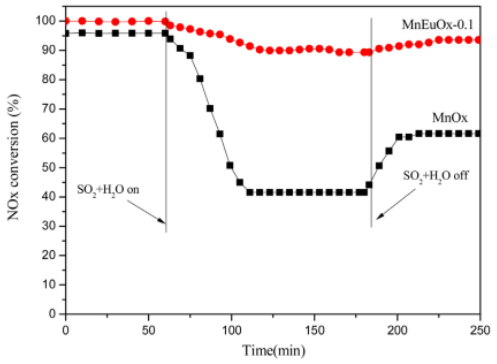
Figure 12. Effect of SO 2 and H 2 O on the SCR activities of MnO x and MnEuO x ‐ 0.1 catalysts (Reaction conditions: [NO] = [NH 3 ] = 600 ppm, [SO 2 ] = 100 ppm, [H 2 O] = [O 2 ] = 5%, balance Ar, GHSV = 108,000 h − 1 , reaction temperature = 350 ◦ C). (Reproduced with permission from Reference [34], Copyright 2017,